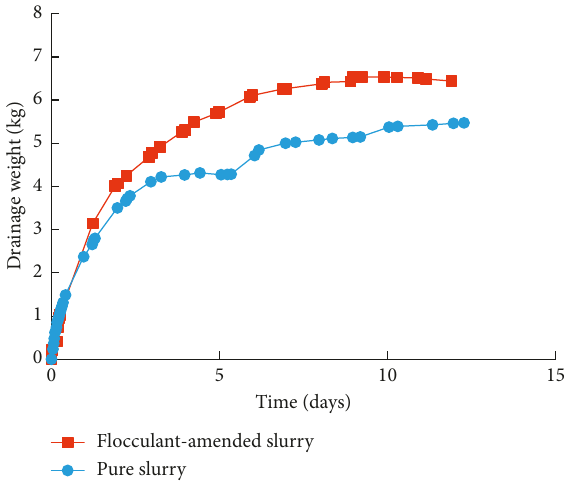
Figure 7: Drainage weight versus time in the vacuum preloading test.